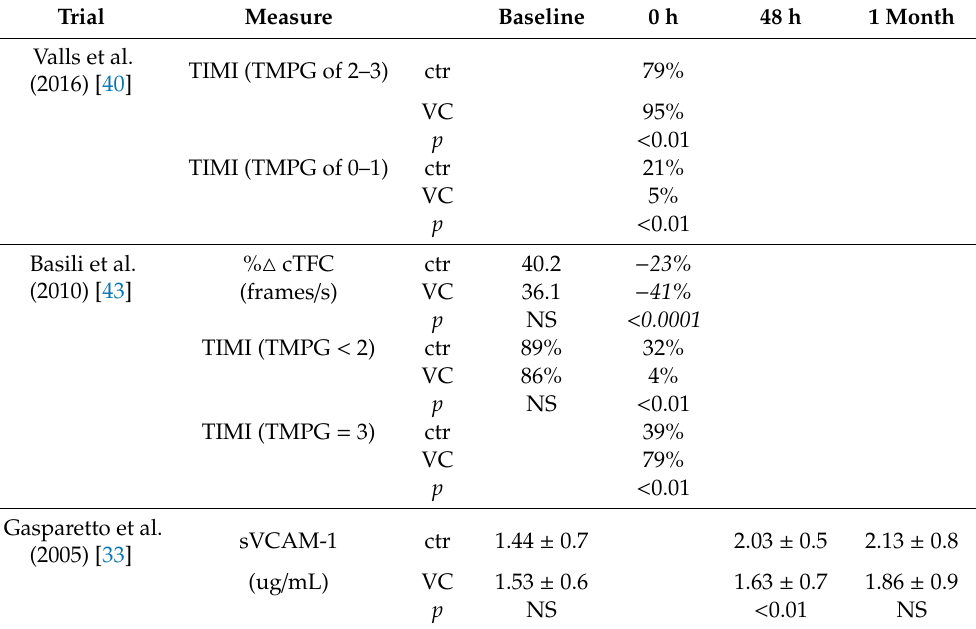
Table 5. E ff ect of Vitamin C on Reperfusion Indices and Vascular Endothelial Dysfunction. Trial Measure Baseline 0 h 48 h 1